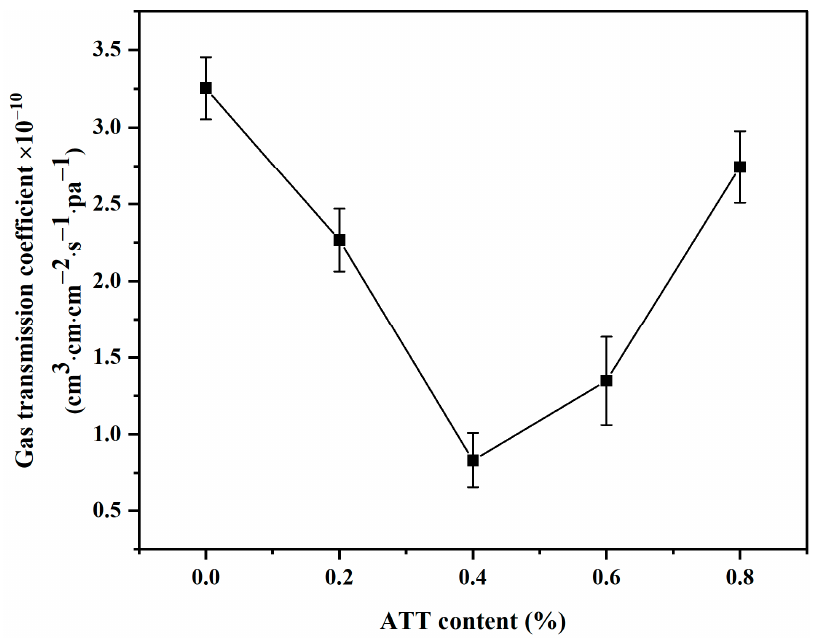
Figure 10. Gas transmission coefficients for MPP and MPP/ATT nanocomposites.